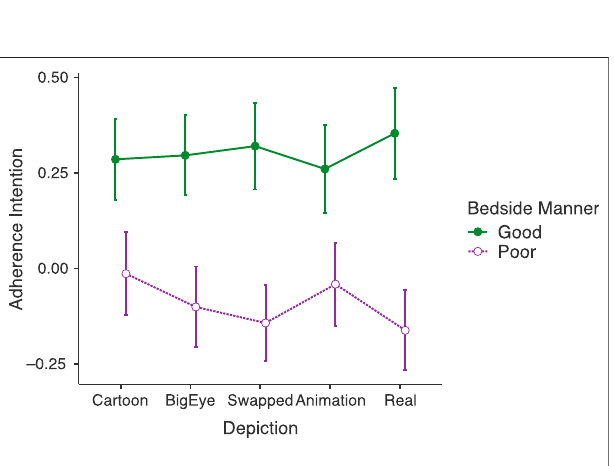
FIGURE 5 | Mean and 95% confidence interval of Adherence Intention by beside manner and depiction.